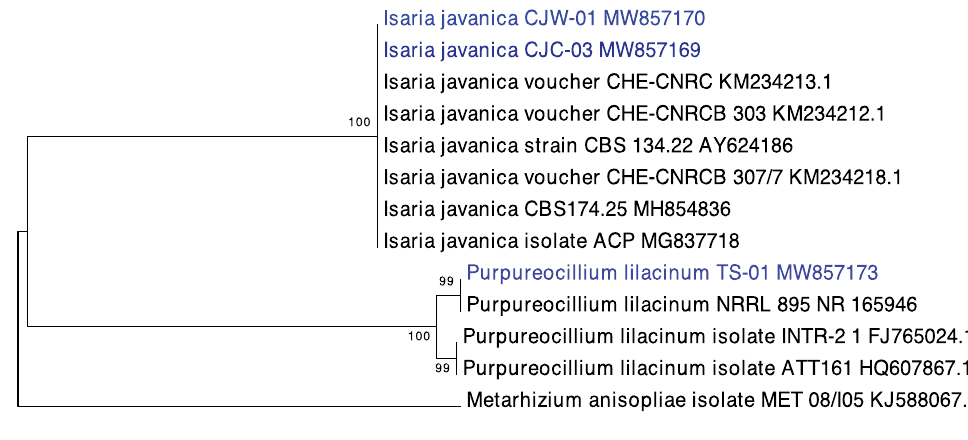
Fig. 3 Maximum likelihood (ML) tree of Isaria javanica isolates and Purpureocillium lilacinum isolate based on ITS region. Metarhizium anisopliae was used as an outgroup